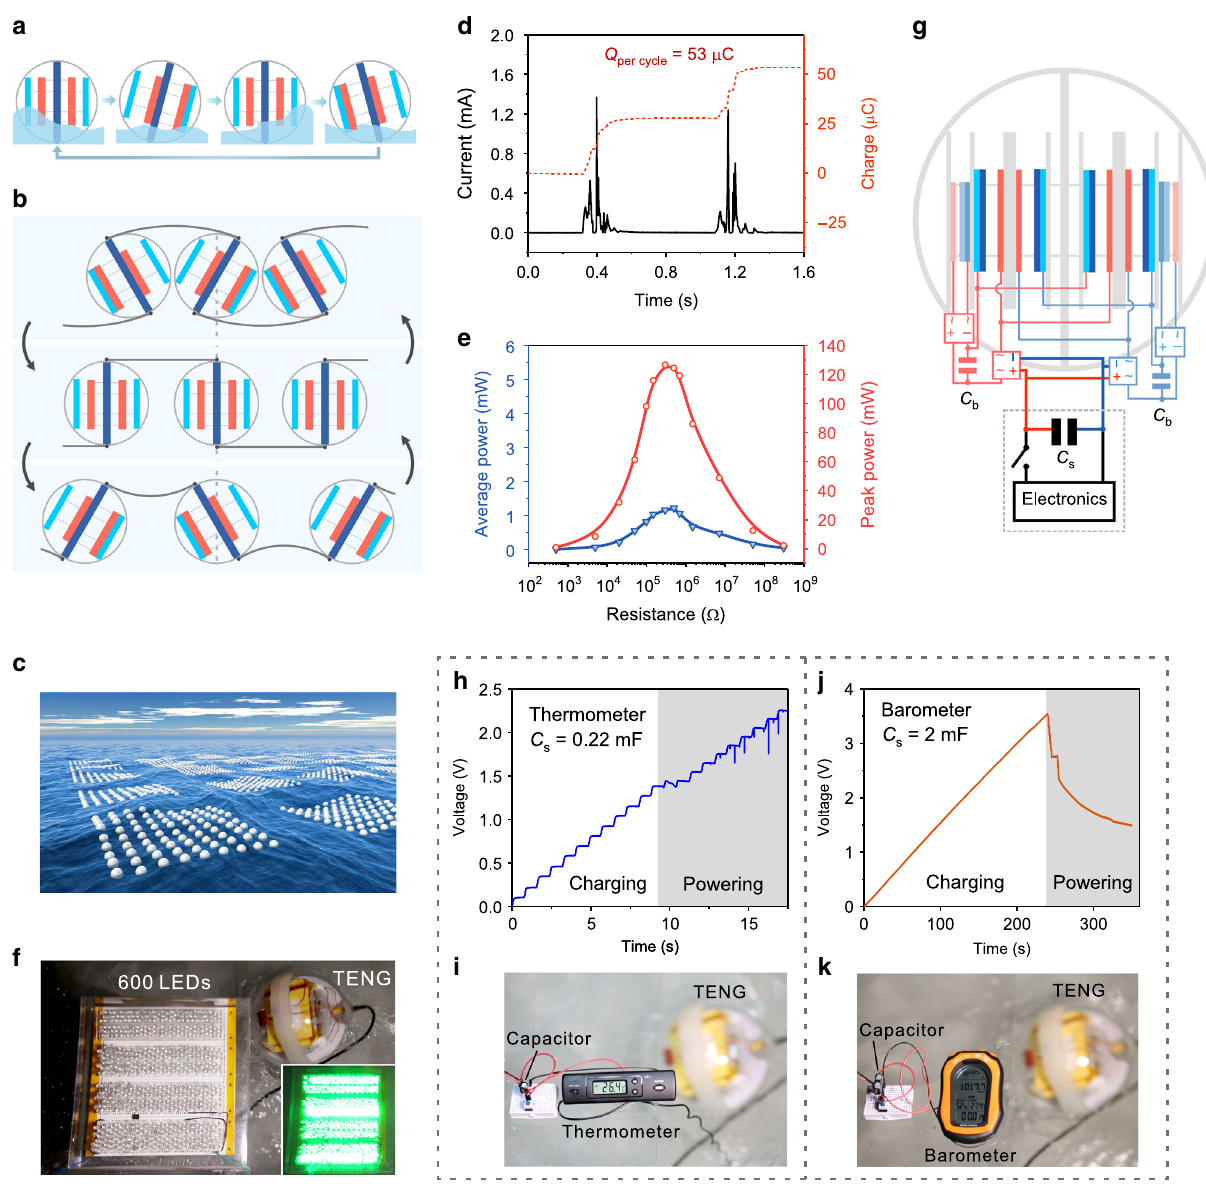
Fig. 5 Performance of the integrated device for water wave energy harvesting. a , b Working principle of a single integrated device ( a ) and networked devices ( b ) in water waves. c Schematic perspective of large-scale networks based on the integrated CS-TENG device for harvesting ocean blue energy. d Detailed output current and charge curves of the integrated device agitated by water waves. e Peak power and average power of the integrated device with various loads in water waves. f Directly powering 600 light emitting diodes (LEDs) by a single integrated device. g Circuit diagram of the integrated device for powering electronics. h – k Voltage curves of the storage capacitor and photographs for the integrated device powering a thermometer ( h , i ), and a barometer ( j , k ). The wave frequency is 0.625 Hz. Source data are provided as a Source Data fi